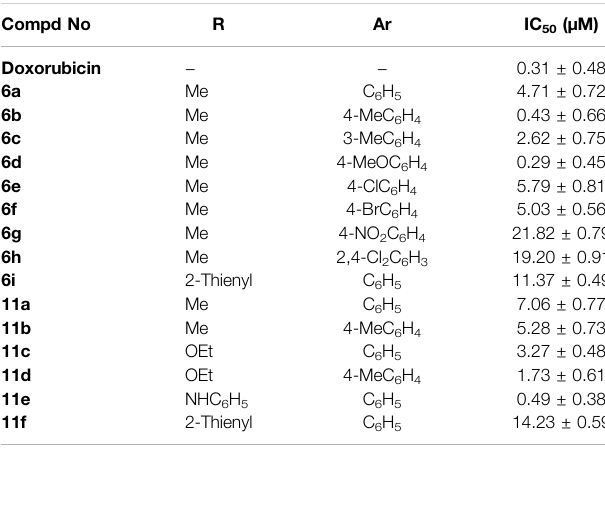
TABLE 5 | Cytotoxic activities of tested compounds against